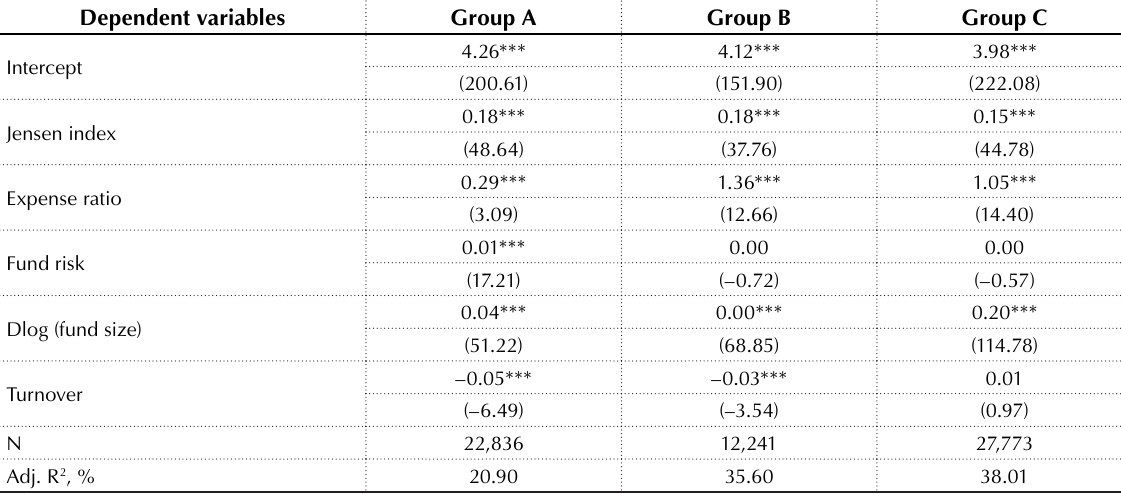
Table 9. Groups regression model of fund outflow